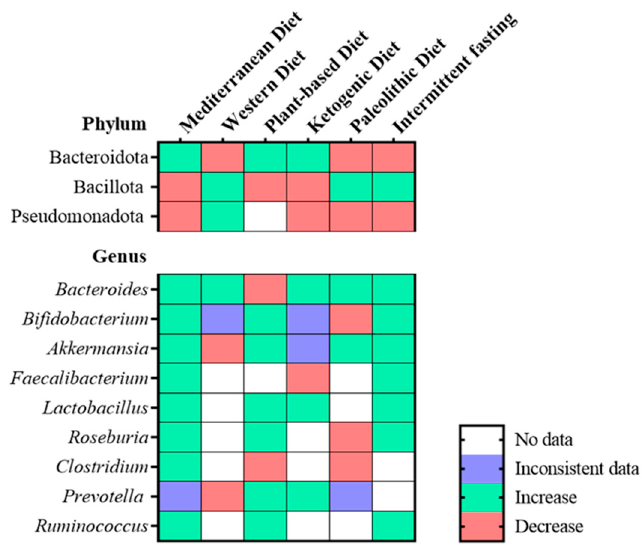
Figure 2. Heatmap representing the changes in the most prevalent bacteria found in the GM at the phylum and genus level in the Mediterranean diet, Western diet, plant-based diet, ketogenic diet, paleolithic diet and intermittent fasting [33,76,86,94,98,102–108].